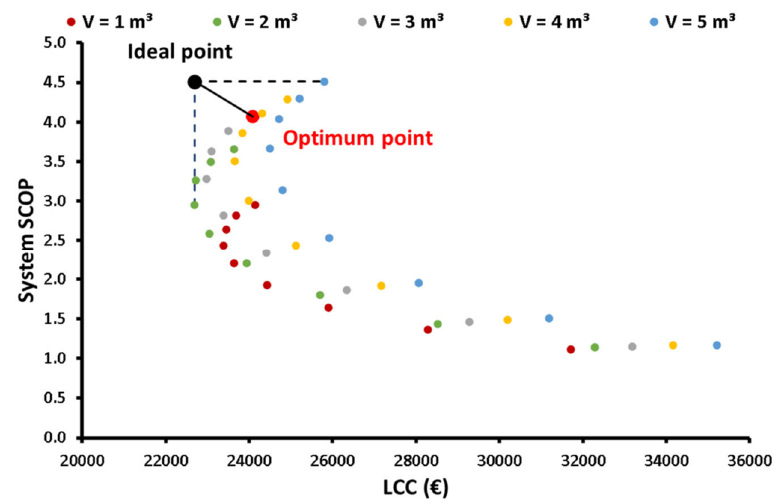
Figure 16. Illustration of the multi-objective optimization process of the system aiming for the maximization of the system SCOP and the minimization of the LCC.